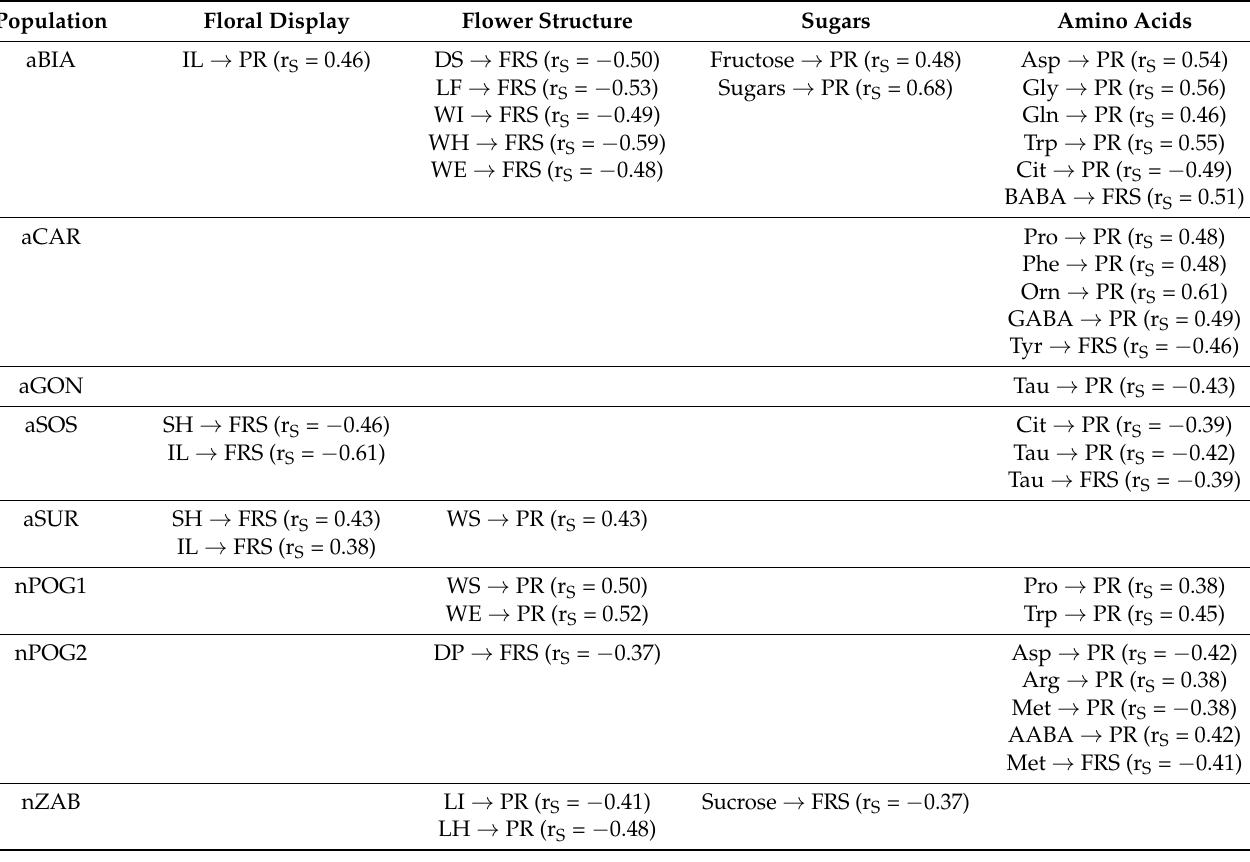
Table 6. Impact of floral display, flower structures, and nectar composition on the reproductive success of Epipactis helleborine